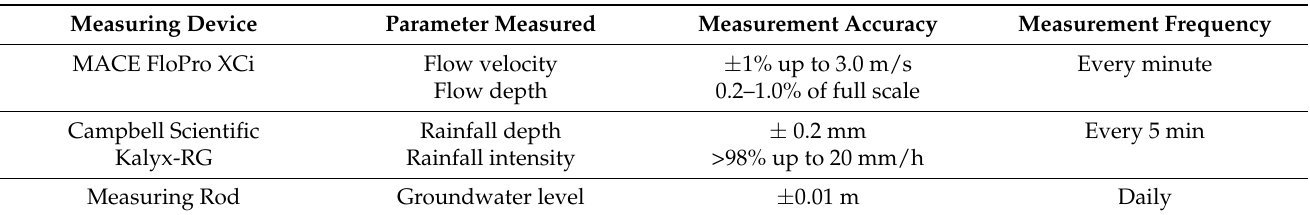
Table 2. Characteristics of the measuring equipment used during the